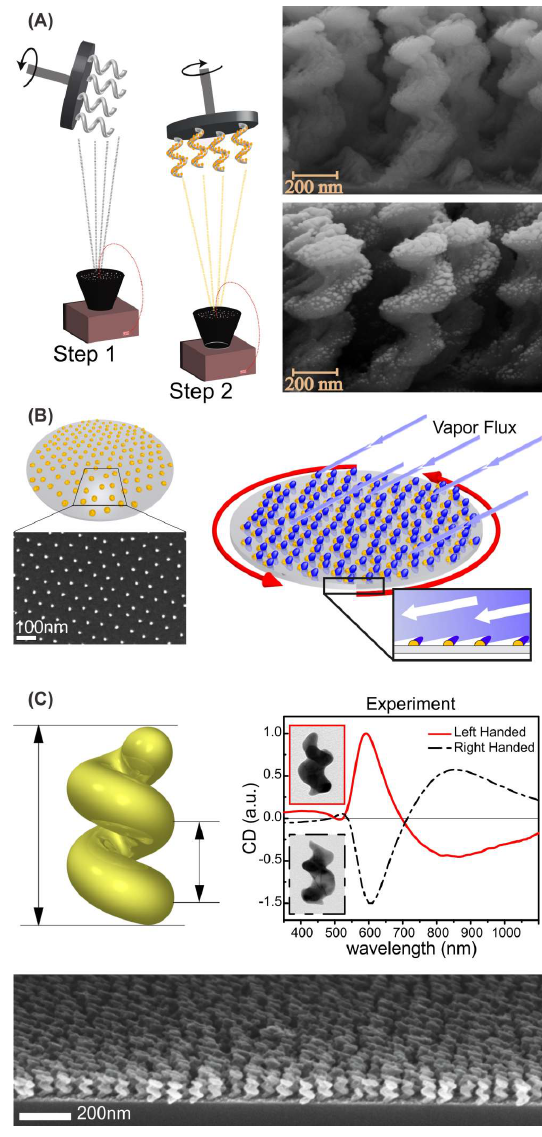
Figure 7: (A) Schematics of hybrid GLAD approach (left). Under a glancing angle, silica helices are created as depicted in the scan- ning electron micrograph in the top-right. Afterwards, under a small tilt angle silver is deposited. The final structures are shown in the scanning electron micrograph in the bottom-right (reprinted with permission from [49]. Copyright 2013 Royal Society of Chem- istry). (B) Illustration and scanning electron micrograph of a pre- structured substrate with gold nanoparticles (left), as well as illus- tration of GLAD process (right). Scale bar corresponds to 100 nm. (C) Blueprint of the helical gold structure (left). Experimental circu- lar dichroism spectra for left- and right-handed helices in solution are depicted on the right with corresponding transmission elec- tron micrographs as insets. The scanning electron micrograph in the bottom panel depicts an array of silver-copper alloy helices be- fore release to solution (B-C reprinted with permission from